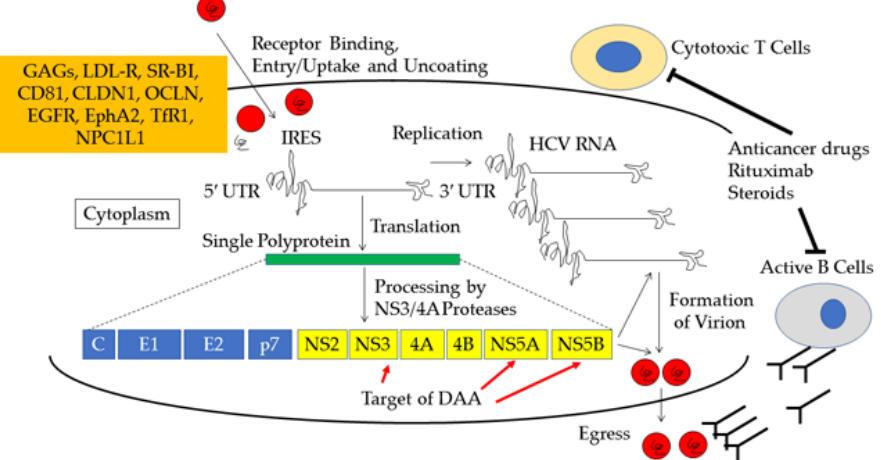
Figure 1. Life cycle of hepatitis C virus (HCV) and mechanism of HCV acute exacerbation and direct-acting antivirals (DAA). Candidates of HCV receptors: glycosaminoglycans, GAGs; low-density lipoprotein receptor, LDL-R; scavenger receptor class B type I, SR-BI; claudin-1, CLDN1; occludin, OCLN; epidermal growth factor receptor, EGFR; ephrin receptor A2, EphA2; transferrin receptor 1, TfR1; Niemann–Pick C1-like 1, NPC1L1. IRES, internal ribosomal entry site; UTR, untranslated region; C, core; E1 and E2, envelope glycoproteins 1 and 2; p7, transmembrane protein 7; NS, nonstructural protein. See the references [75,89].